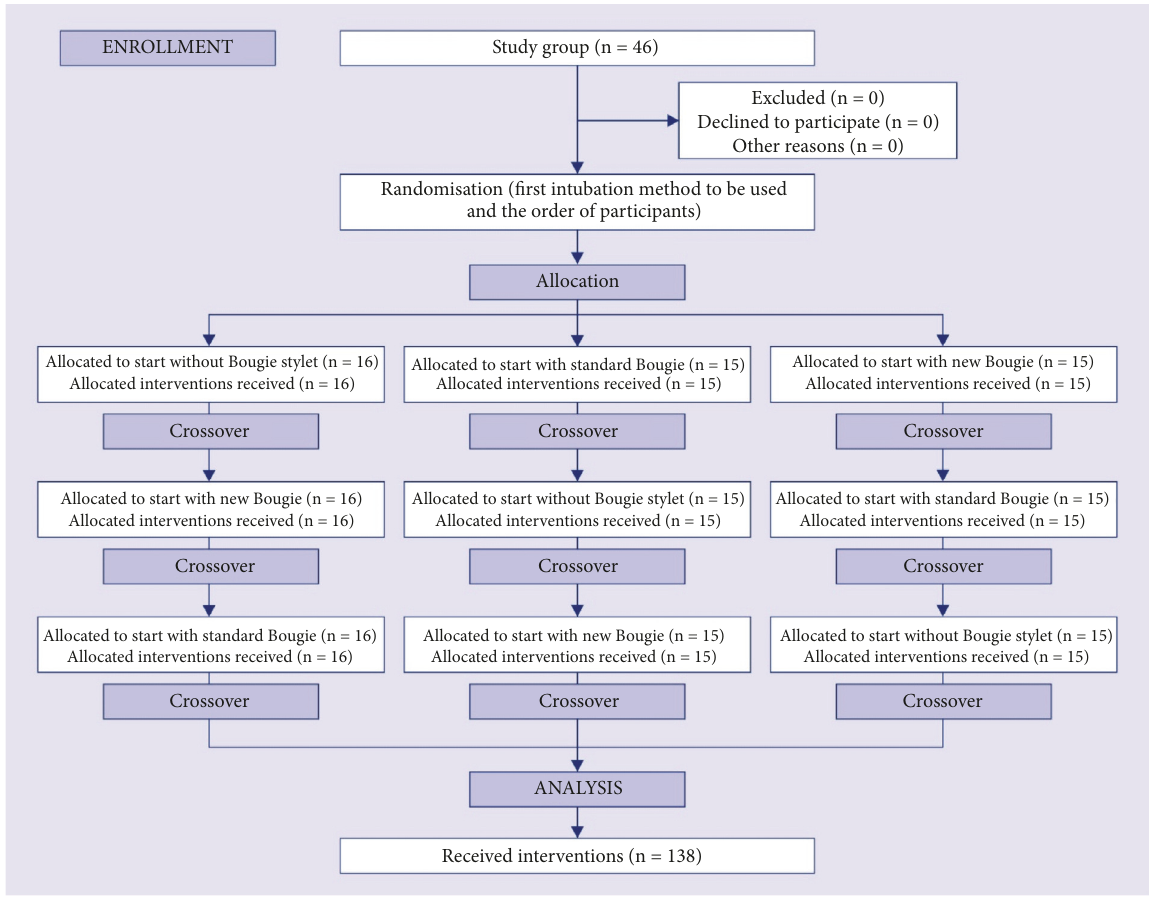
Figure 2: Randomization flow